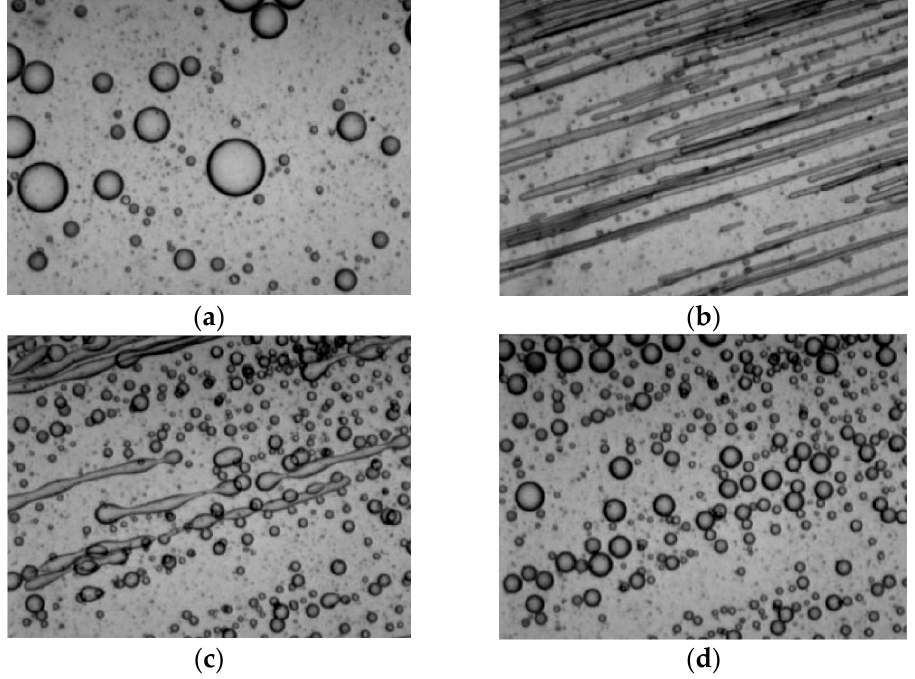
Figure 2. Morphology of the dispersed phase in PDMS/PB blends. ( a ) Before shearing; ( b ) during shearing; ( c ) 25 s after shearing stop; ( d ) 89 s after shearing stop (experimental results from the literature [6]).